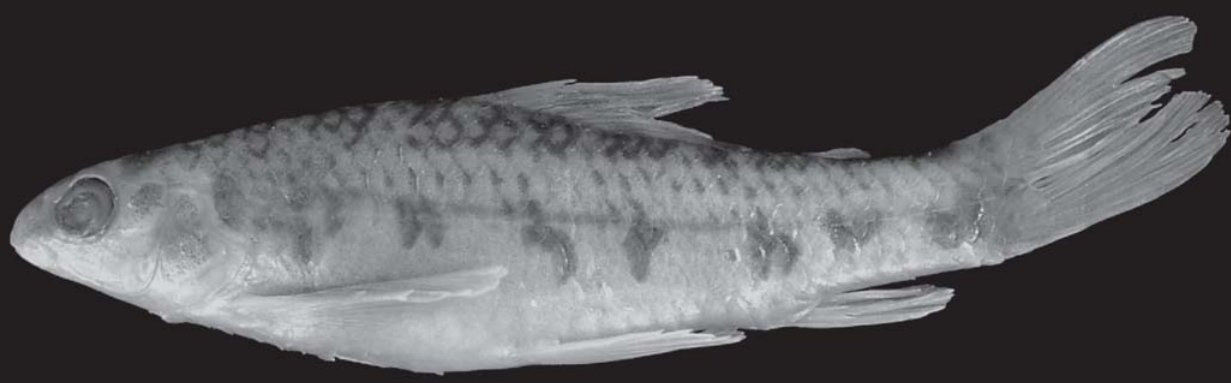
Fig. 2 . Characidium heirmostigmata , paratype, NUP 1393, 40.8 mm